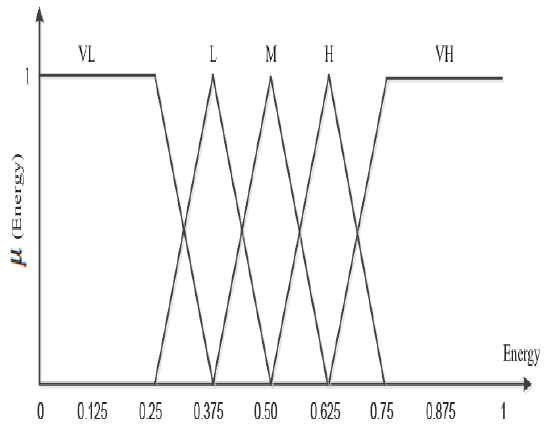
Figure 3. Fuzzy membership function for energy